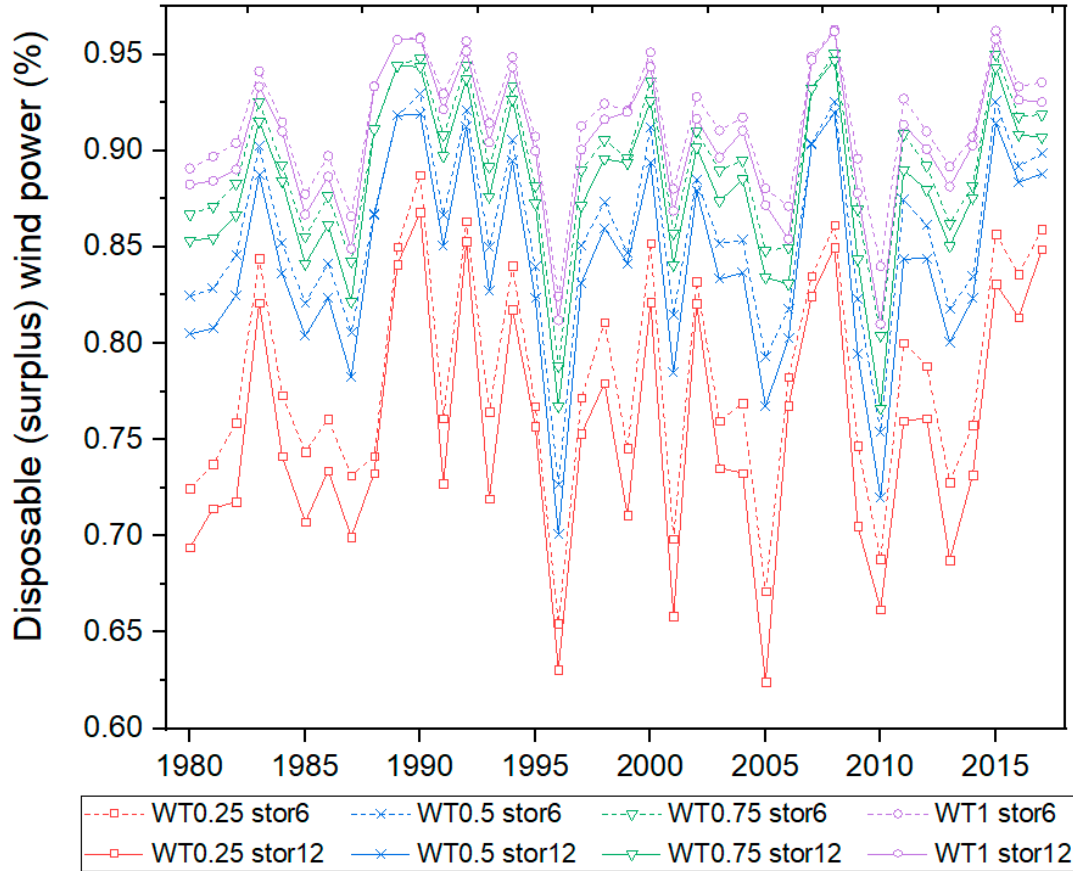
Figure 3. The share of surplus wind power (energy rejected) for various configurations of wind power and heat storage over 37 consecutive years of observation. The capacity of the geothermal source equalled 0.5. Abbreviations used in the graph: WT–wind turbines capacity; stor–heat storage capacity. Explanation of labels: WT0.25 stor6 means that the considered system consisted of a geothermal heat source of size 0.5, heat storage with capacity of 6 units and a wind farm capacity of 0.25. Units used in the graph are extensively explained in Appendix A.